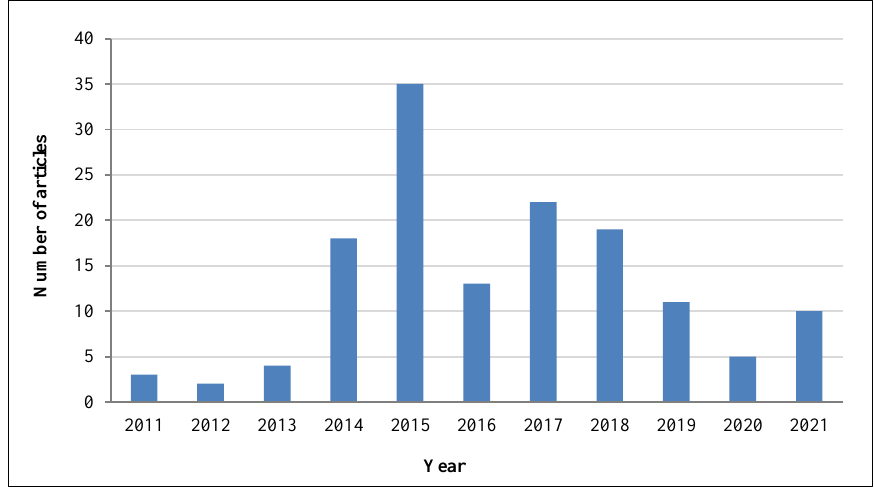
Figure 3. Time distribution of